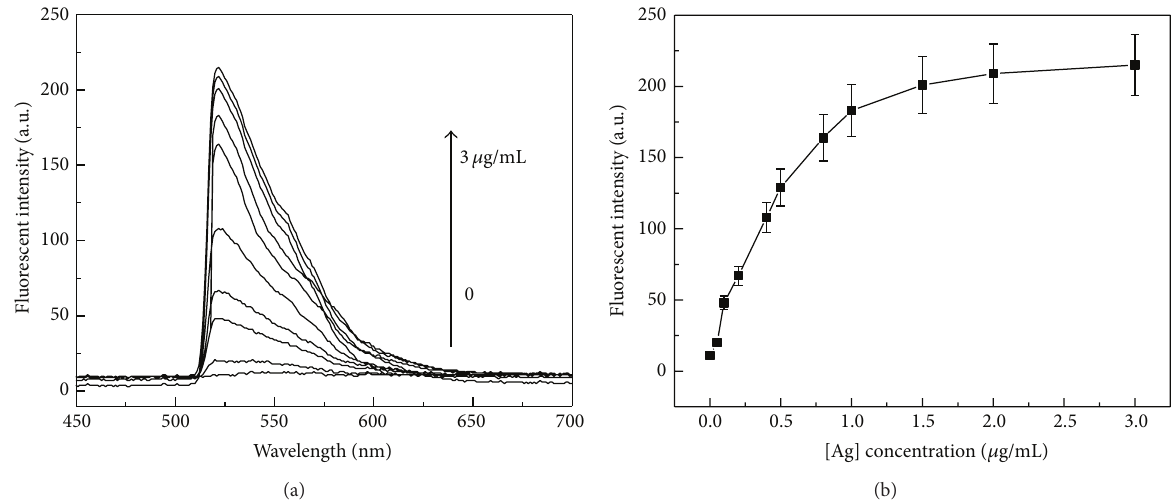
Figure5:TheFITC-labelledanti-humanIgGimmunoassayanditsworkcurveinthissystem.(a)SpectraofhumanIgGinseriesconcentration in the reactions. From curves 1 to 7 the human IgG concentration was 0 ng/mL, 30 ng/mL, 50ng/mL, 100 ng/mL, 0.2 𝜇 g/mL, 0.4 𝜇 g/mL, 0.5 𝜇 g/mL, 1.0 𝜇 g/mL, 1.5 𝜇 g/mL, 2.0 𝜇 g/mL, and 3.0 𝜇 g/mL. (b) The correlation of fluorescent intensity and concentration of human IgG. The data were repeated for 3 times.